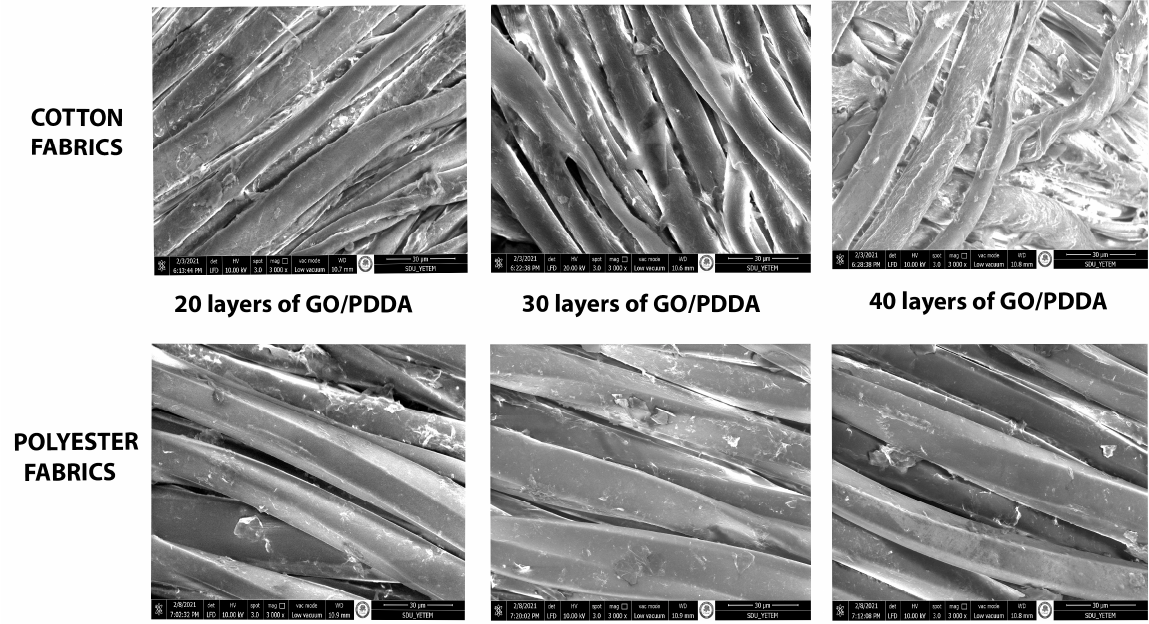
Figure 5. SEM micrographs of GO-multilayer-coated